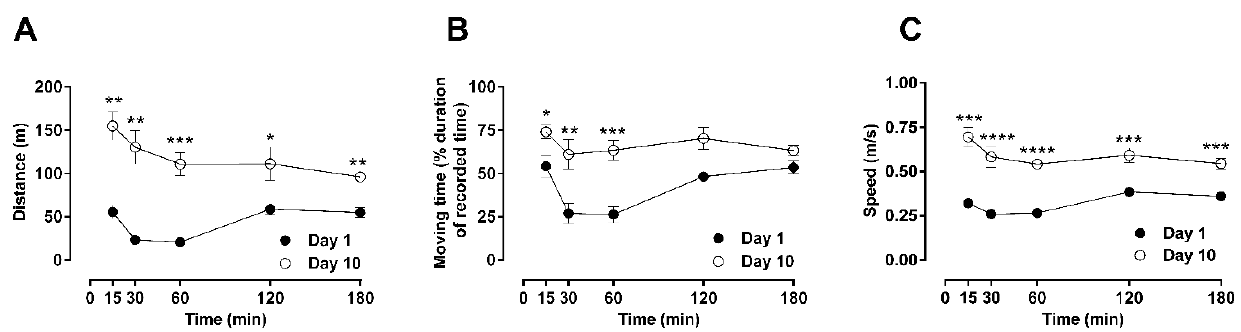
Figure 1. Time-resolved basic locomotor activity after repeated morphine administration (10 mg/kg, b.i.d. over 10 days). Locomotor parameters were recorded in an open-field arena after a single subcutaneous injection of morphine on day 1 or day 10 in male Sprague–Dawley rats. The motor behavior of treated animals was assessed by quantification of total distance traveled ( A ), total moving duration ( B ), or average speed ( C ), for a period of 180 min post-administration. Statistically significance ( p < 0.05) at a specific time-point against the effects of day 1 is shown as * p < 0.05, ** p < 0.01, *** p < 0.001, and **** p < 0.0001 and was calculated using unpaired t -test. Values are presented as mean ± SEM ( n = 6 animals per group). Error bars are sometimes too small to be visible. The behavioral differences between these two days are shown as the differences in their area under the curves (AUC) in Table 1, which indicates that differences were observed in the distance, moving time, and